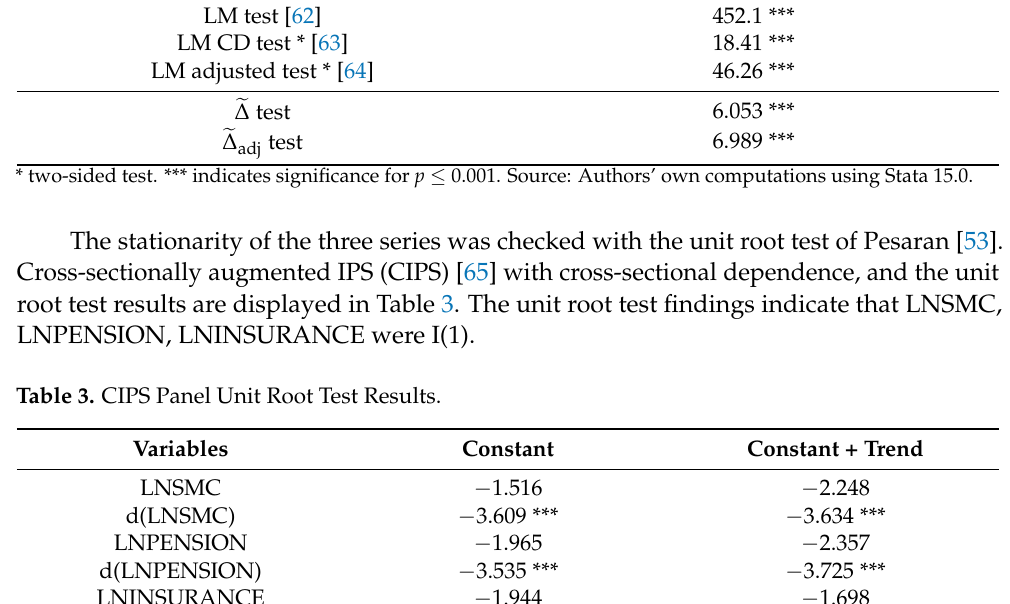
Table 2. Cross-Sectional Dependence and Homogeneity Tests’ Results. Test Statistic